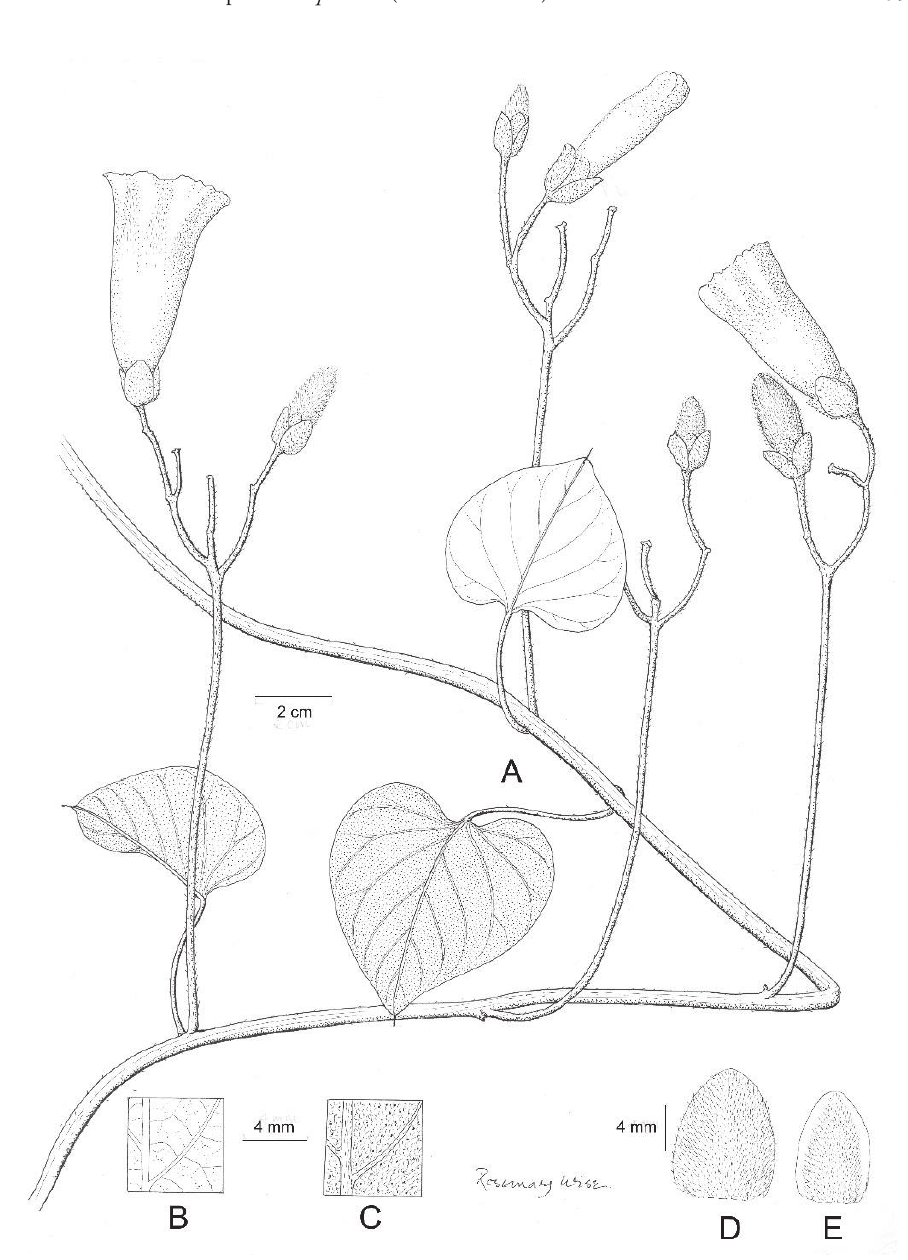
Figure 19. Ipomoea walteri. A habit B adaxial leaf surface C abaxial leaf surface D outer sepal e inner sepal. Drawn by Rosemary Wise from B.M.T. Walter et al.